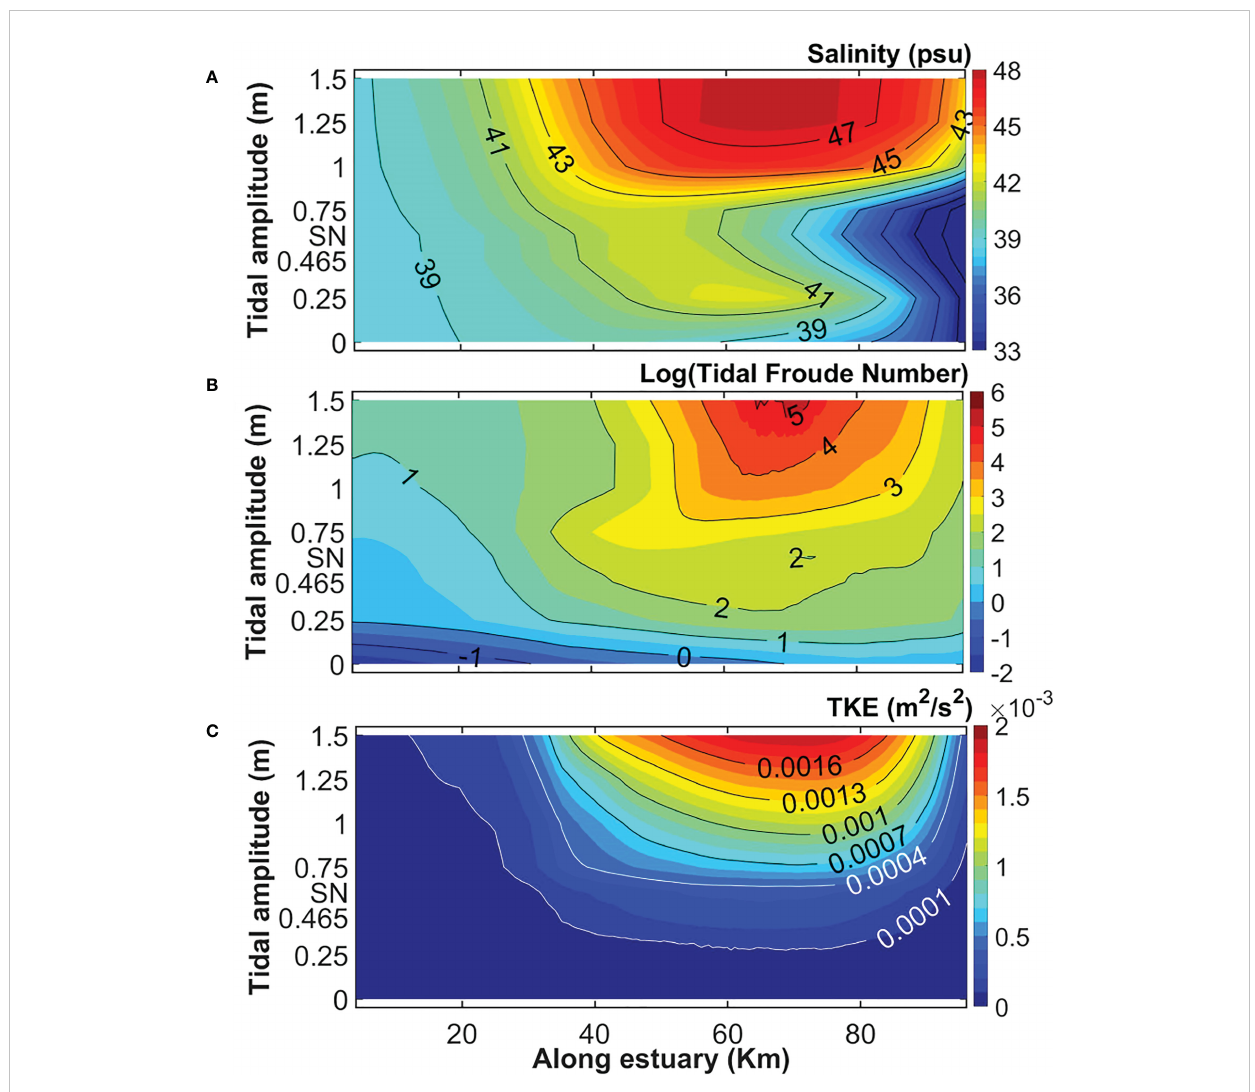
FIGURE 7 The tidally averaged depth-mean axial salinity (A) , the logarithm of tidal Froude number (B) and the turbulent kinetic energy TKE (C) from 8 scenarios of EXP4-EXP11 (see Table 1), as a function of distance from the estuary mouth (x-axis) and tidal amplitudes at the estuary mouth (y-axis). “ SN ” on the y-axis stands for the spring-neap scenario of EXP11.